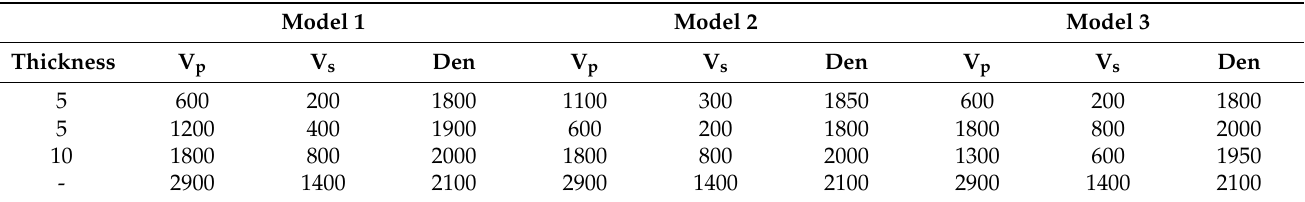
Table 2. We simulate the surface-wave fields with a vertical concentrated force source (a 25 Hz Ricker wavelet) at the surface. With the sample interval of 0.5 ms, there are 49 receivers arrayed in line at the surface with 1 m intervals and the nearest offset is 5 m. Table 2. The model parameters.